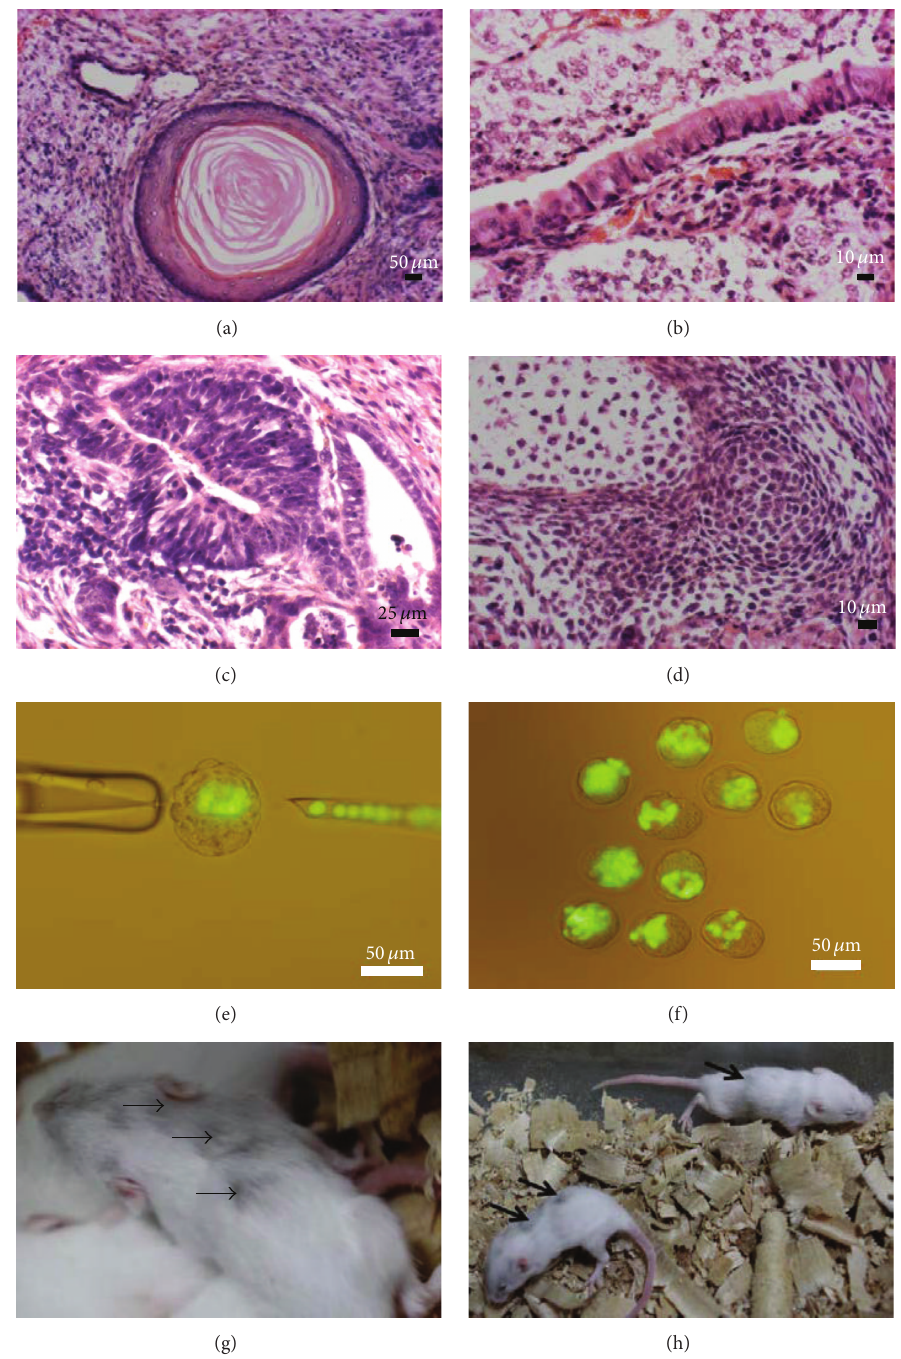
Figure 9: Pluripotency characterization of ESC-like cells with teratoma formation including tissue structures of all germ layers (a–d) and chimera formation (e–h). (a) Skin formation with keratinizing squamous epithelium, (b) respiratory epithelium with goblet cells, (c) neuronal rosette, and (d) primitive cartilage. (e, f) Blastocysts injected with GFP-marked ESC-like cells and chimera formation. Scale bars: (a), (e), and (f) 50 𝜇 m, (b) and (d) 10 𝜇 m, and (c) 25 𝜇